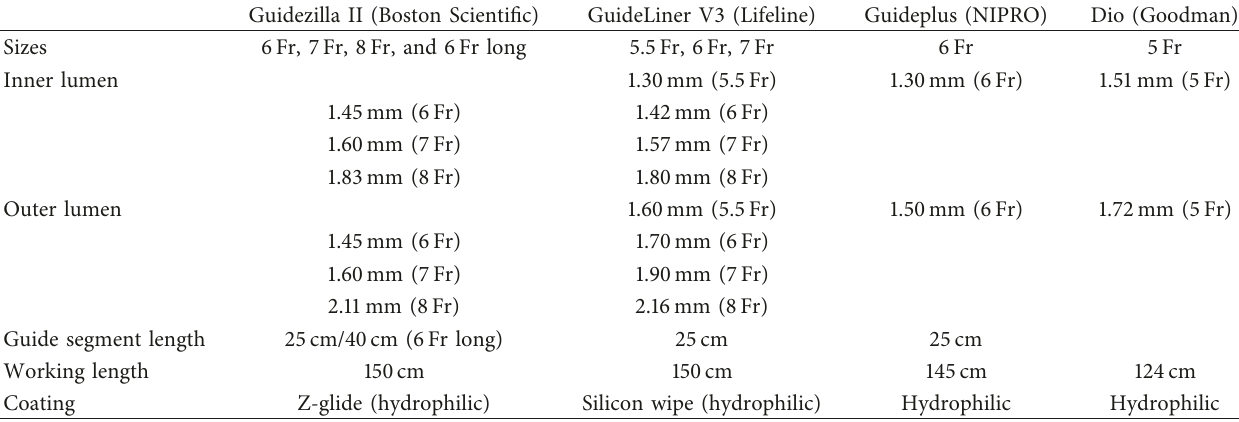
Table 1: Design comparison of the guide extension catheter available in Japan and Dio thrombus aspiration